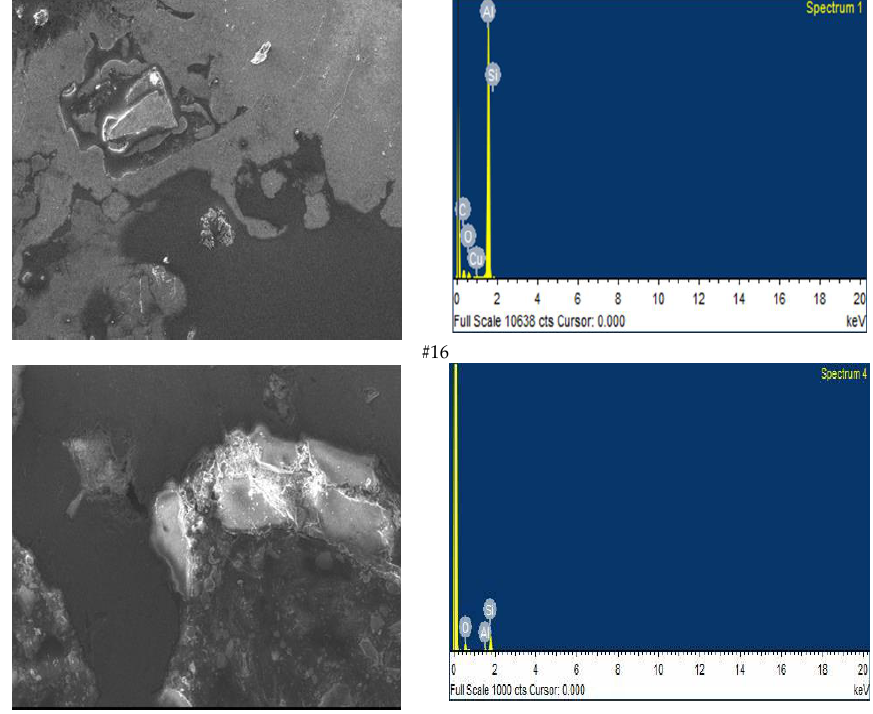
Figure 2. Fish bone diagram for prepared castings.